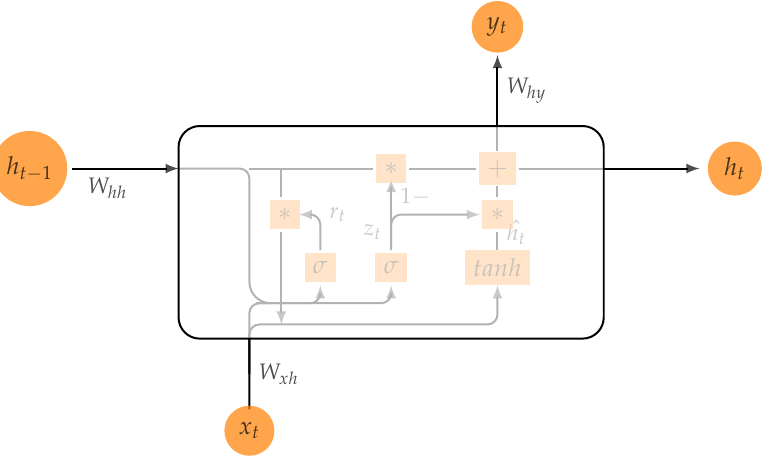
Figure 4. Structure of